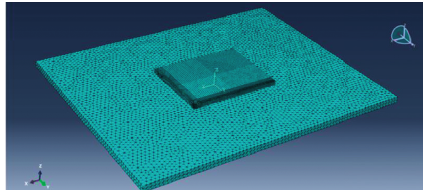
Figure 2: Overall meshing effect of three-dimensional finite ele- ment model for cement